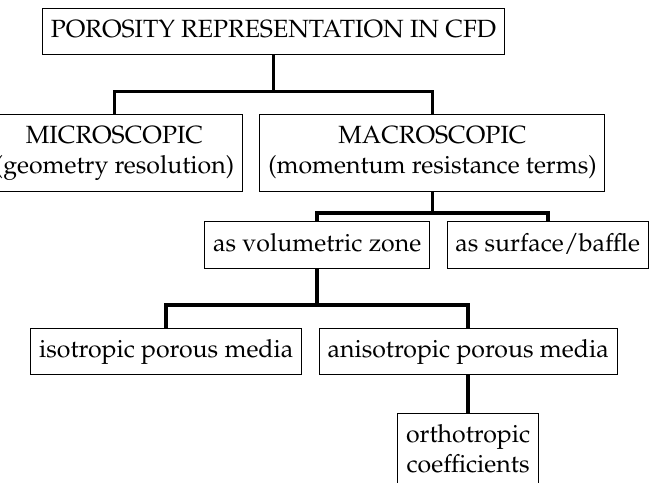
Figure 1. Options for porosity representation in computational fluid dynamics (CFD) modeling for thin porous structures.